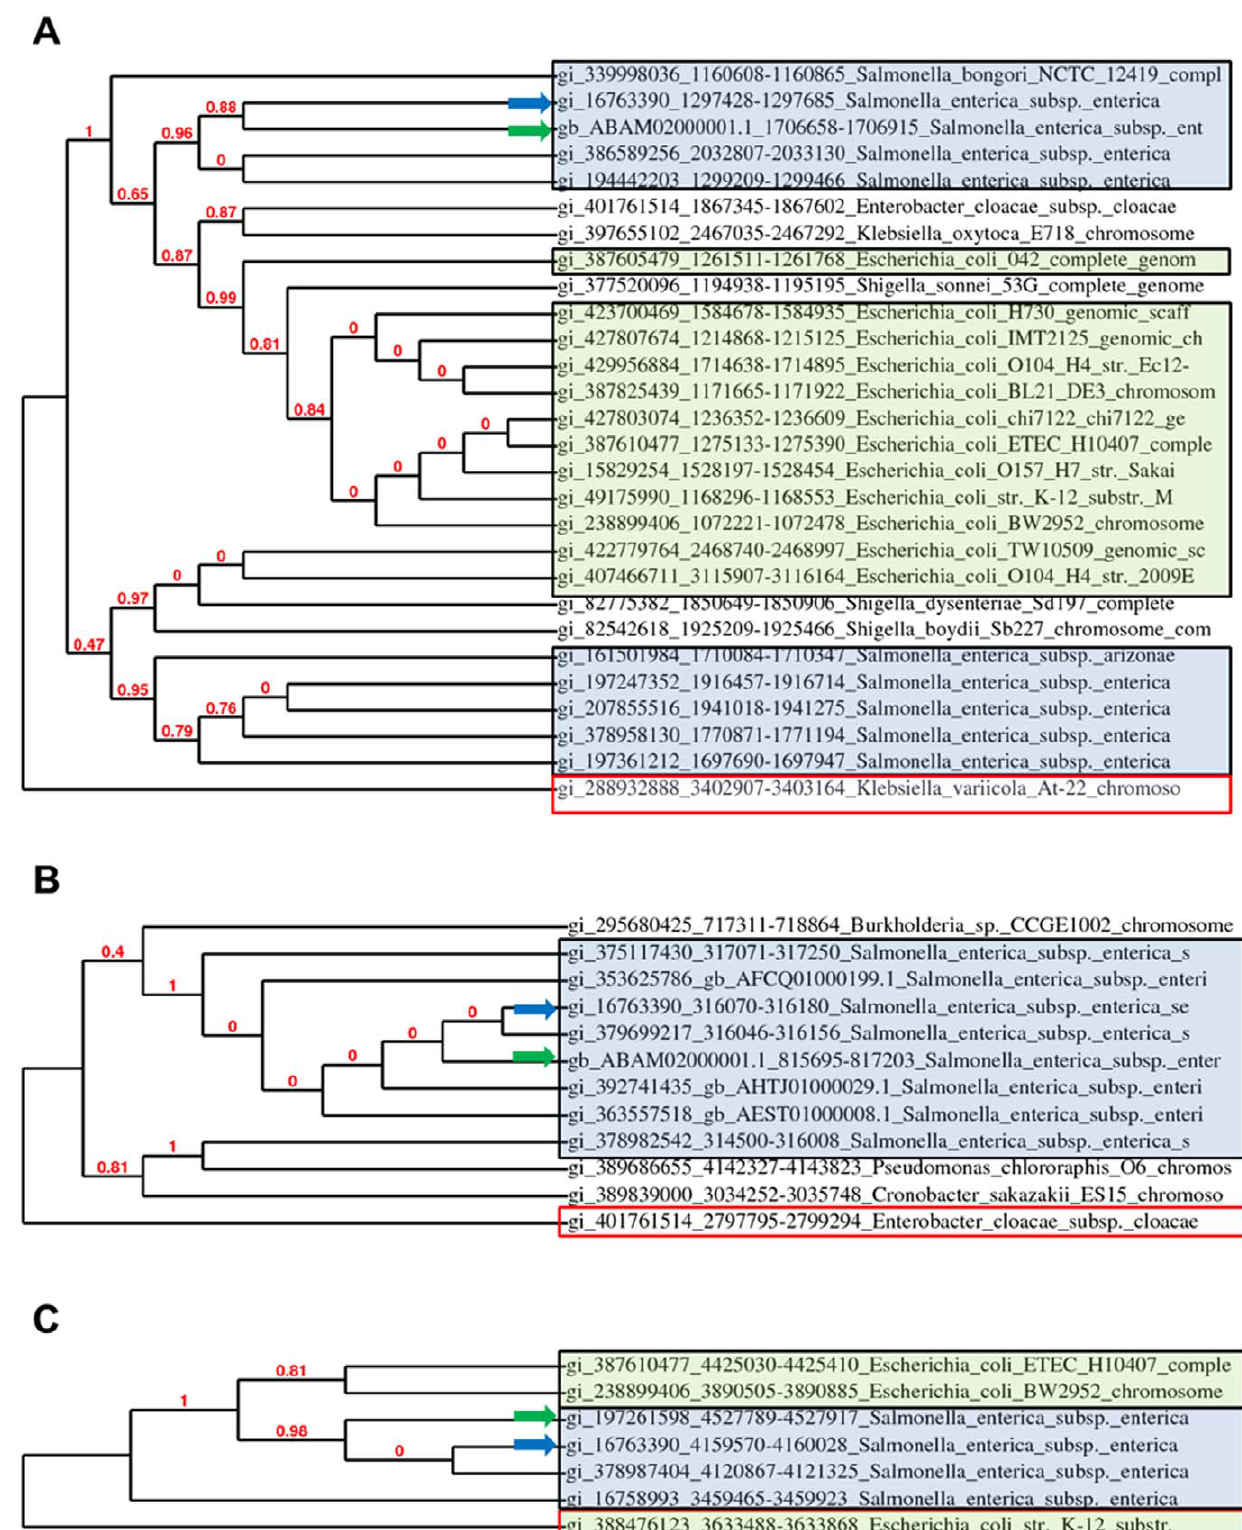
Figure 1. Phylogenetic relatedness of ycfR , sirA , and yigG in S.enterica and their homologs in related bacterial species. Cladograms for ycfR (A), sirA (B), and yigG (C) with branch support values displayed at nodes were reconstructed using PhyML 3.0 aLRT and TreeDyn 198.3. (http:// www.phylogeny.fr/) (22–28). Salmonella sp. and E. coli sp. are indicated by blue and green boxes, respectively. An outgroup is indicated with a red box. Blue and green arrows indicate locations of S. Typhimurium and S. Saintpaul, respectively, in the cladograms.